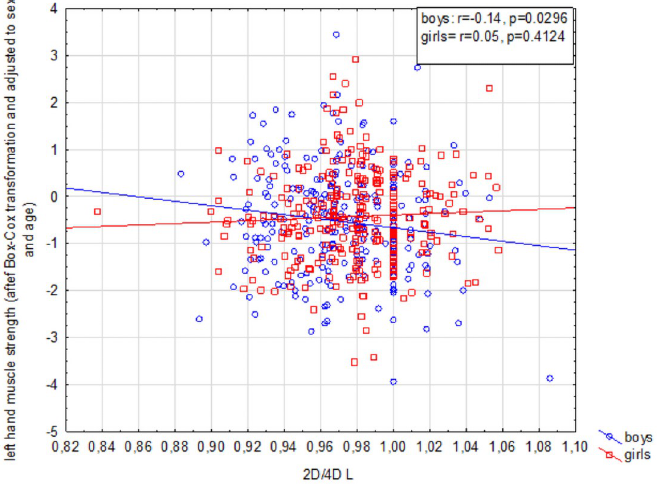
Fig 2. Interaction between 2D:4D L digit ratio and left hand grip strength among children aged 13–16.